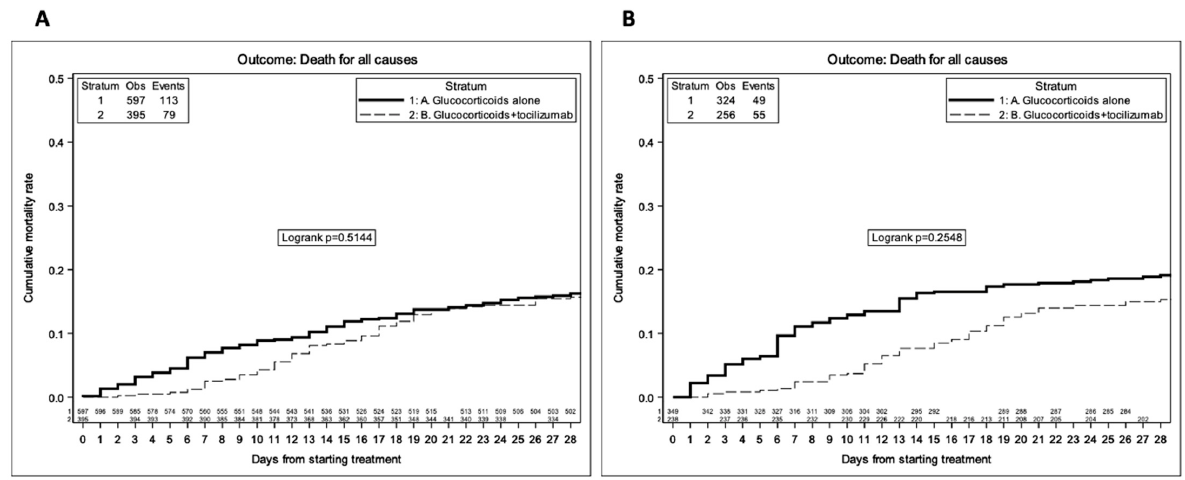
Figure 1. Survival KM estimates stratified by treatment group—unweighted analysis ( A ) and weighted analysis after adjustment for age, ethnicity, CCI, baseline CRP, and PaO 2 /FiO 2 ratio ( B ). Table 4. Unadjusted and adjusted HR of death from fitting Cox regression models—all participants.